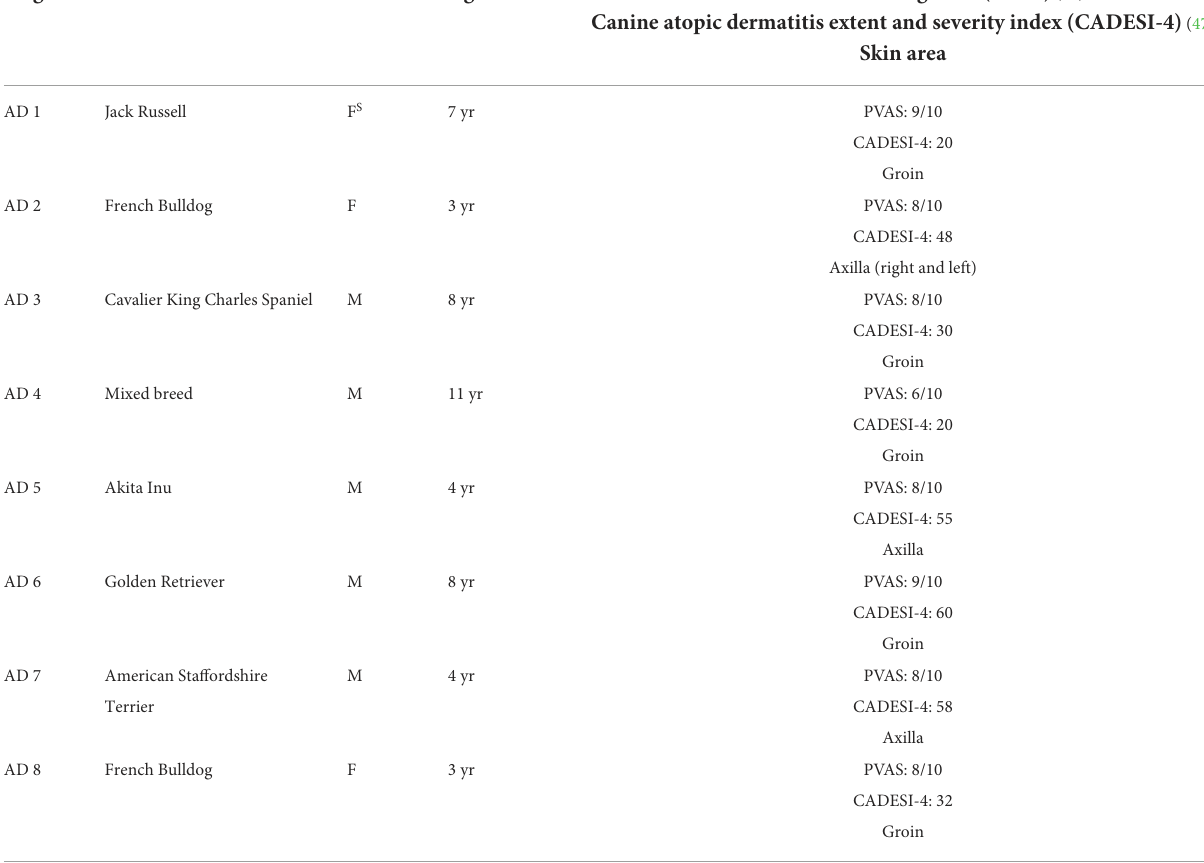
TABLE 1 The clinical data of the dogs with atopic dermatitis (AD) enrolled in the present study. Dogs Breed Sex Age Pruritus visual analog scale (PVAS) (46) Canine atopic dermatitis extent and severity index (CADESI-4) (47) Skin